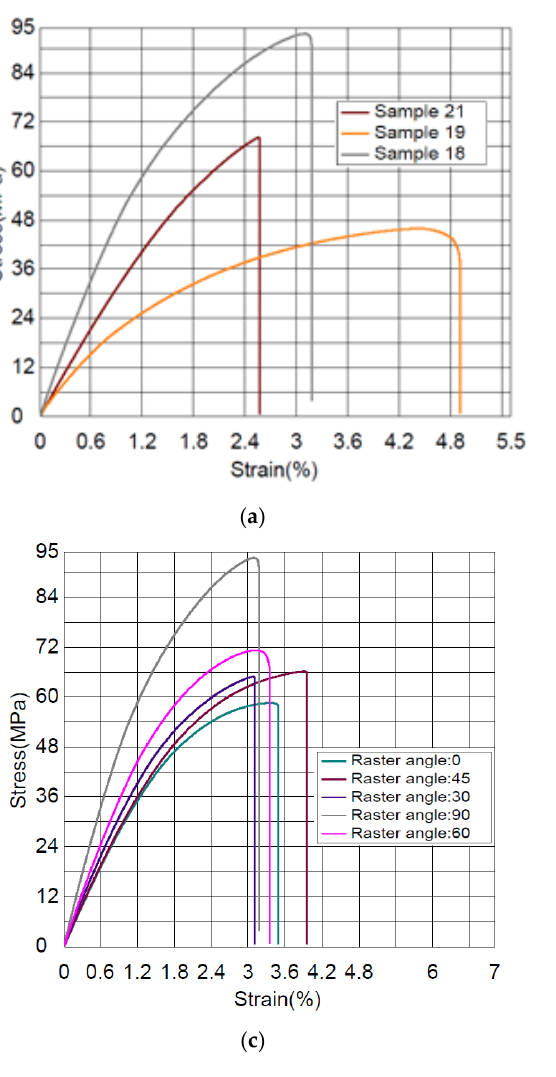
Figure 5. The stress – strain curves: ( a ) material behavior for different process parameters; ( b ) Tensile stress – strain curves at different layer thickness; ( c ) tensile stress – strain curves at different raster angle; ( d ) tensile stress – strain curves at different printing speed.